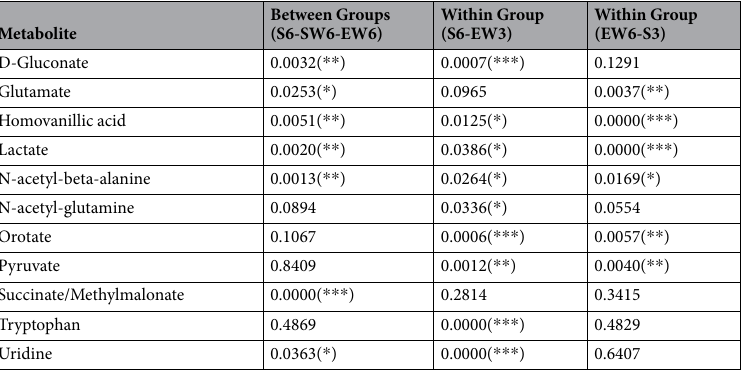
Table 1. Significance levels of the 11 known metabolites with consistent differences between behavioral states. The p-values generally reflect a behavioral state by time interaction, with the sleep conditions decreasing while the wake conditions remained constant (or increase). Pyruvate (S6-SW6-EW6) and orotate (S6-EW3) were the only two exceptions, in that the reported p-values represent a main effect of state and no time interaction). ( * )p < 0.05, ( ** )p < 0.01, ( *** )p < 0.001. Abbreviations: S, sleep; SW, spontaneous wakefulness; EW, enforced